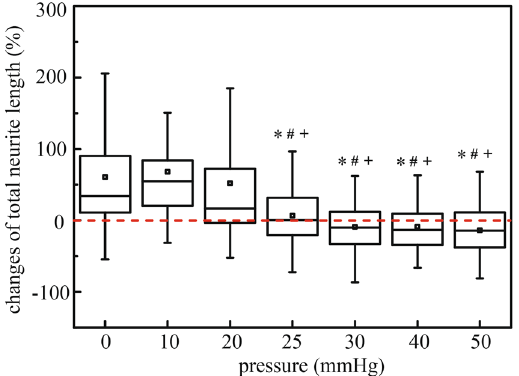
Figure 4. Box plot of percentage of total neurite length changes after applied hydrostatic pressures of 0 mmHg (n = 155 RGCs), 10 mmHg (n = 67 RGCs), 20 mmHg (n = 109 RGCs), 25 mmHg (n = 77 RGCs), 30 mmHg (n = 76 RGCs), 40 mmHg (n = 80 RGCs), and 50 mmHg (n = 74 RGCs) for 72 hours. Box plot whiskers indicate the maximum and minimum values of the data. The symbols * , # and + indicate statistically different results from 0 mmHg (P < 0.05), 10 mmHg (P < 0.05), and 20 mmHg (P < 0.05) respectively by one-way ANOVA followed by Bonferroni post-hoc test.